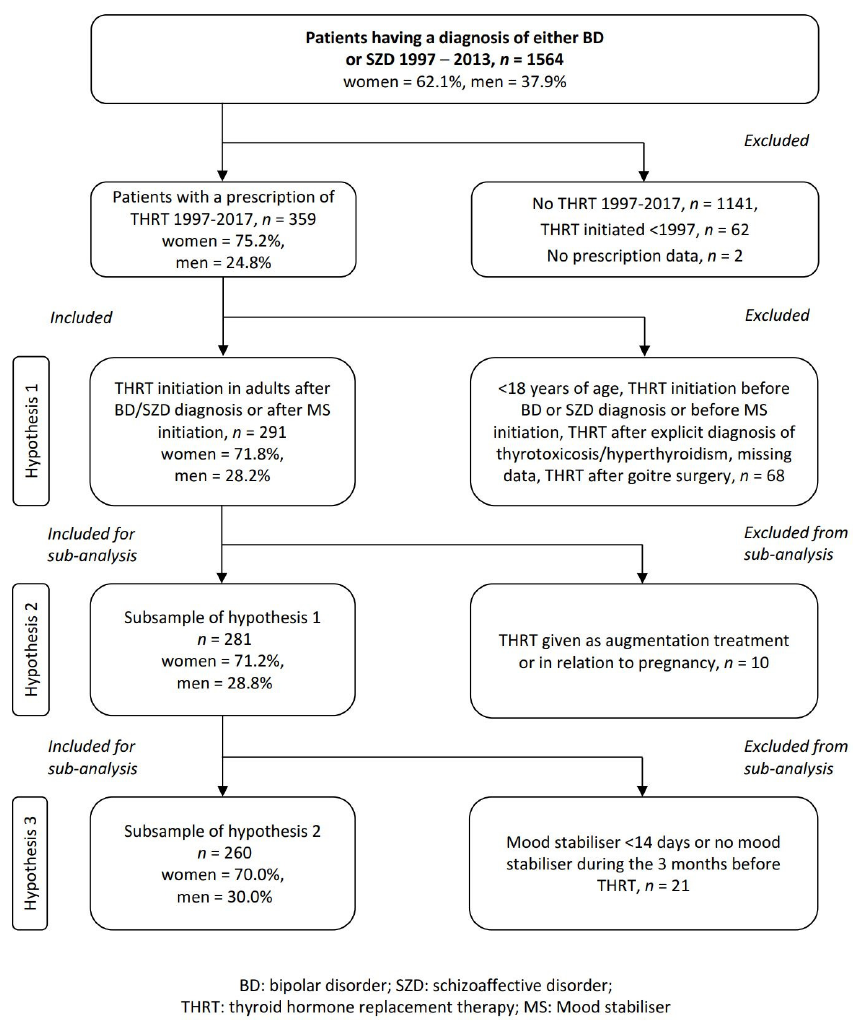
Figure 1. Selection of study sample.